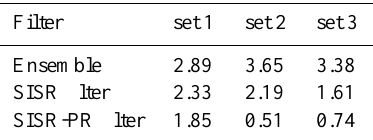
Table 2. RMSE [mm 3 mm − 3 ] between the observed and simulated soil moisture for 3 parameter sets.